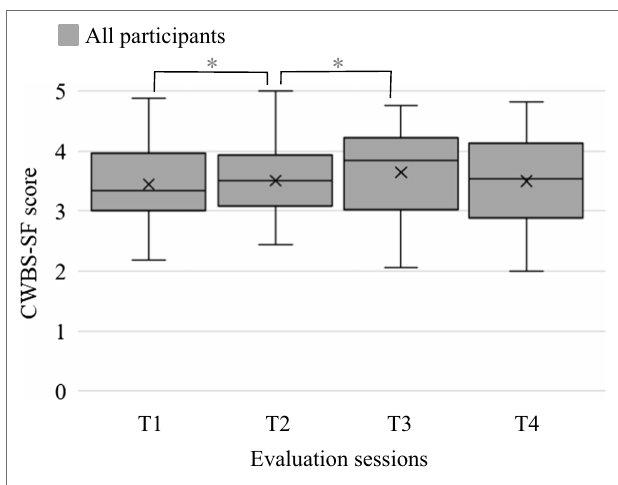
FIGURE 3 | Caregivers’ Well-Being Scale—Short Form (CWBS-SF) score of all participants together at each evaluation point. The box inferior limits represent first quartile of the distribution, and the upper limits the third quartile (median excluded). The lines across the box show the median score of each group. The crosses inside the boxes mark the mean value of each dataset. The whiskers indicate the minimum and maximum distribution values. * p ≤